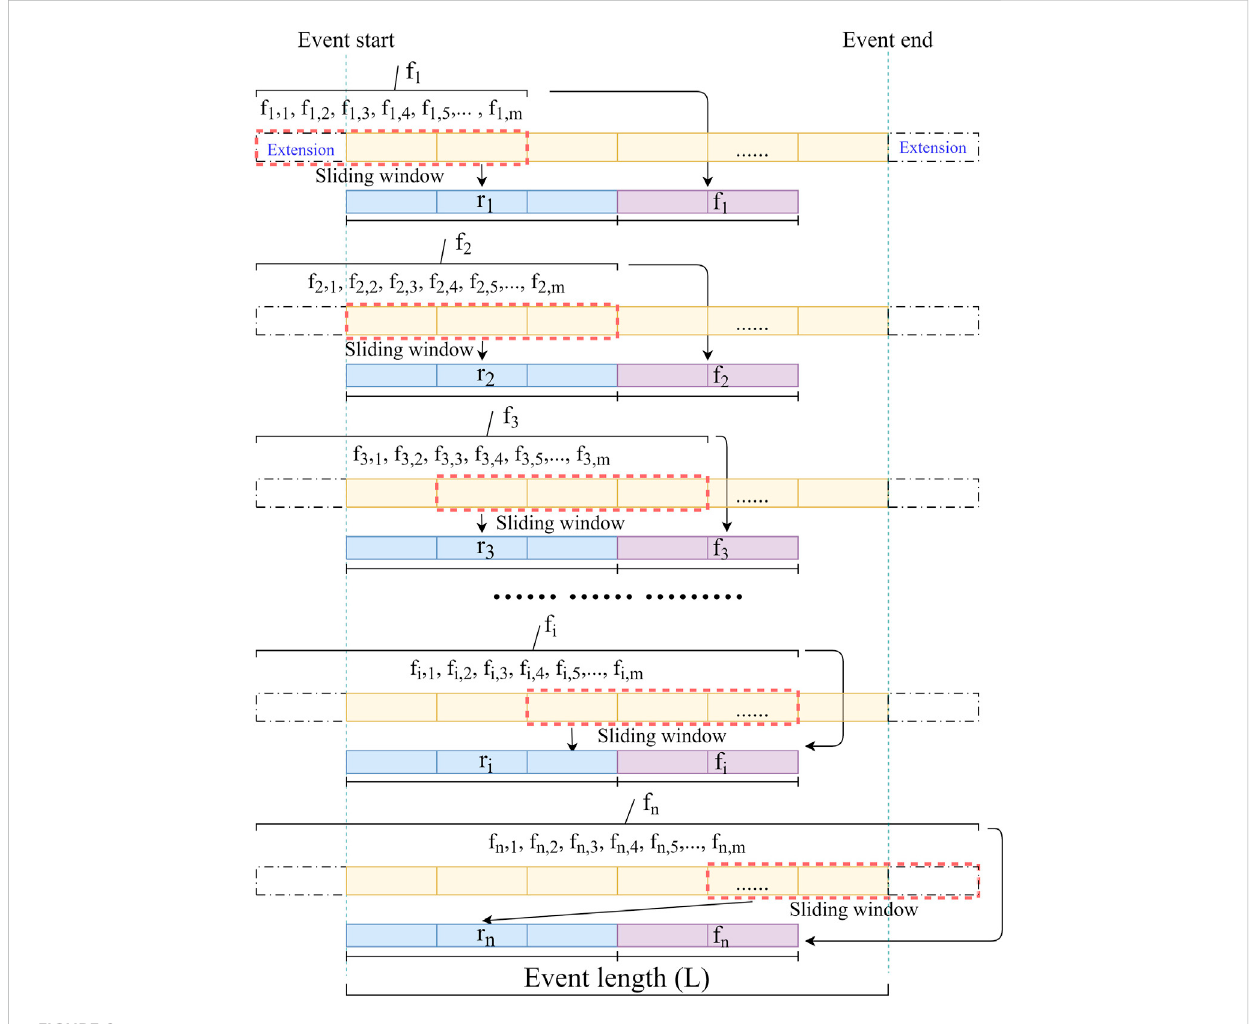
FIGURE 2 Schematic diagram of data slicing and